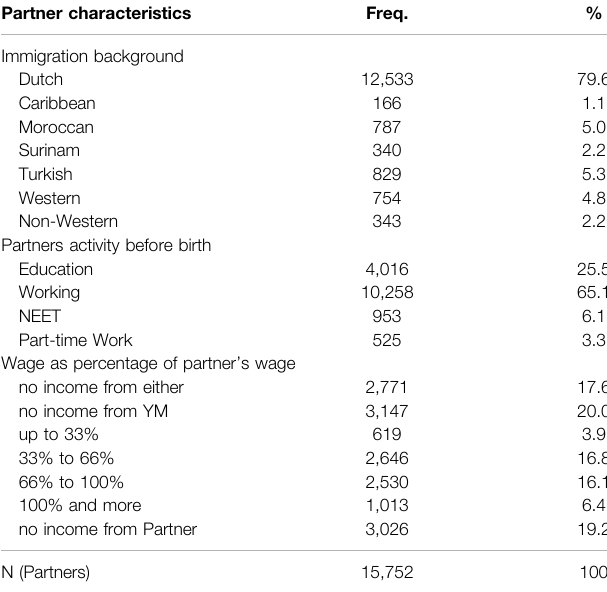
TABLE 1 | Summary statistics of key variables of young mothers. Young mothers ’ characteristics